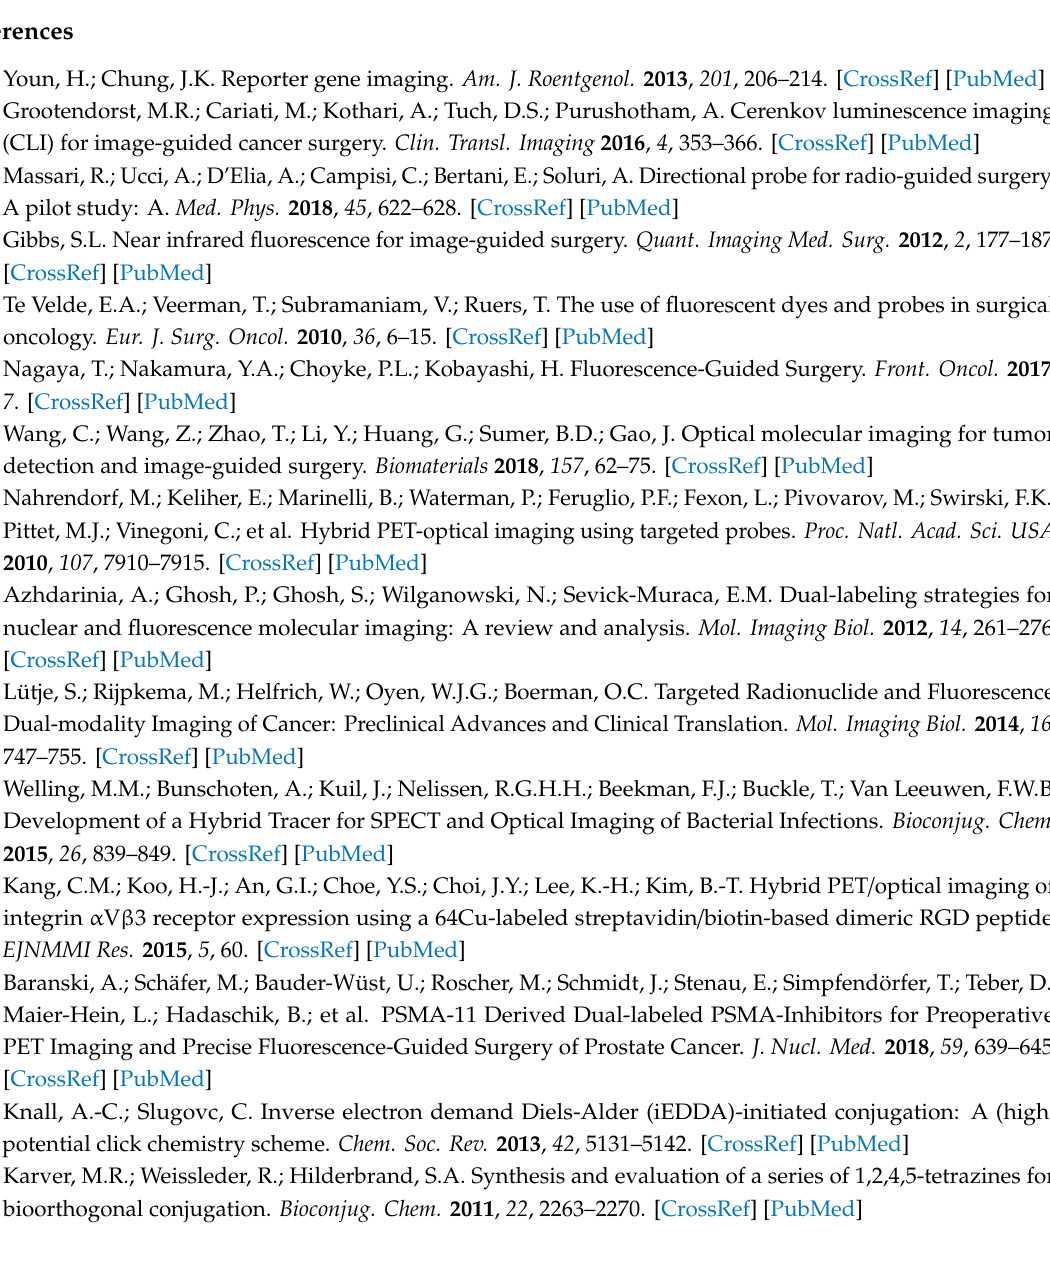
Supplementary Materials: The following are available online, Figure S1: OI and PET Imaging of 68 Ga-labeled IRDdye800CW-MAFC-PEG 5 -Tz in